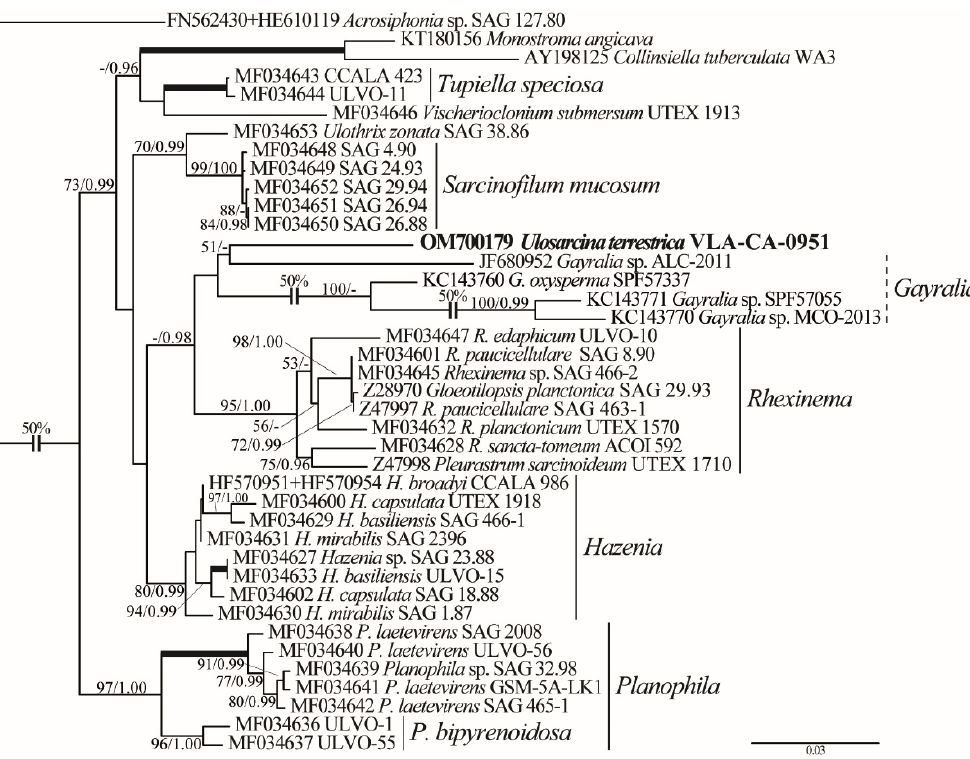
Figure 3. ML phylogenetic tree (TIM2+I+G model) of the Ulotrichales showing the position of the new genus Ulosarcina (boldfaced) based on SSU and ITS rDNA sequence data (2291 aligned positions of 40 sequences). See Figure 2 legend for details.